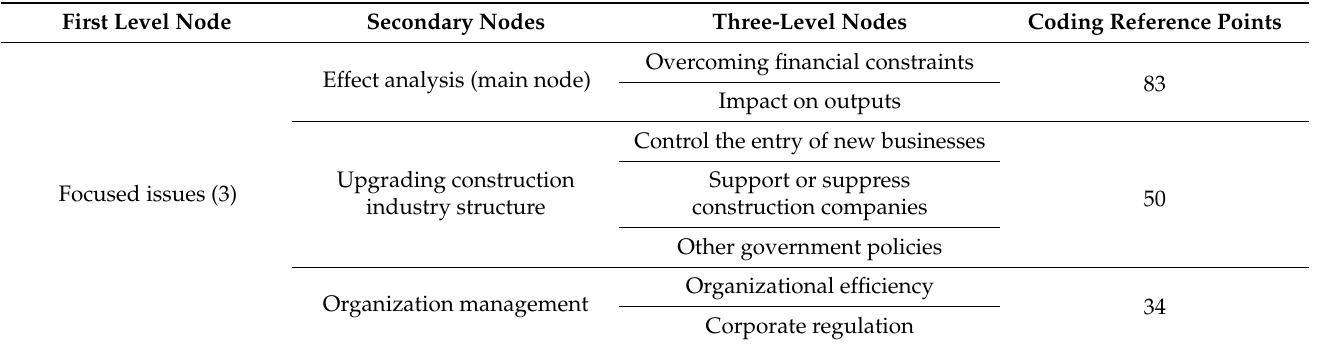
Table 4. Number of nodes and coding reference points in the focused issues node.